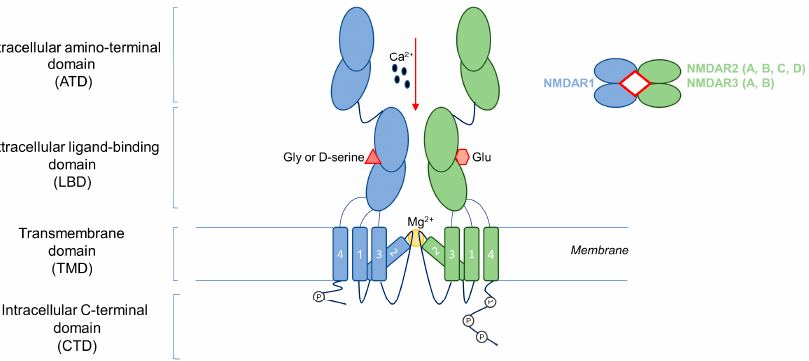
Figure 1. NMDA receptor structure. NMDAR is a heterotetrametric transmembrane receptor con- stituted by two obligatory NMDAR1 subunits and a further two NMDAR2 or NMDAR3 subunits.